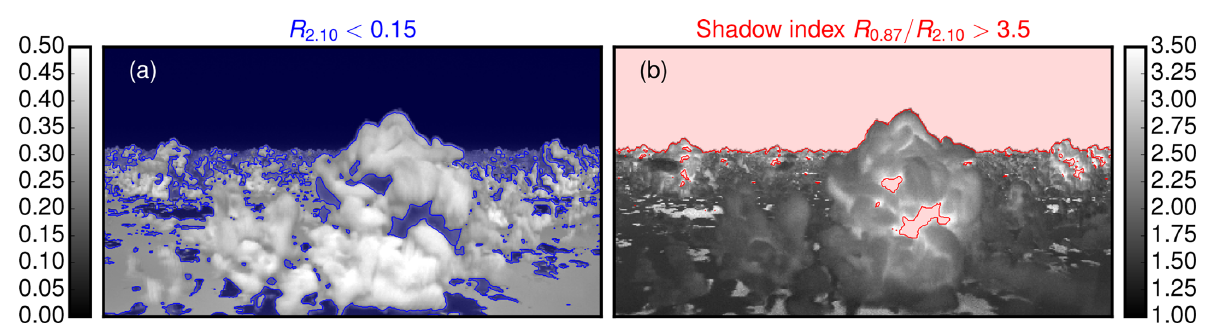
Figure 16. (a) Reflectivity at 2 . 1µm for the cloud scene shown in Fig. 6 (blue regions mark the simple reflectivity threshold R 2 . 10 < 0 . 15). (b) Shadow index R 0 . 87 /R 2 . 10 highlighting regions of enhanced cloud absorption caused by multiple diffuse reflections (red regions mark the shadow index threshold R 0 . 87 /R 2 . 10 > 3 . 5).